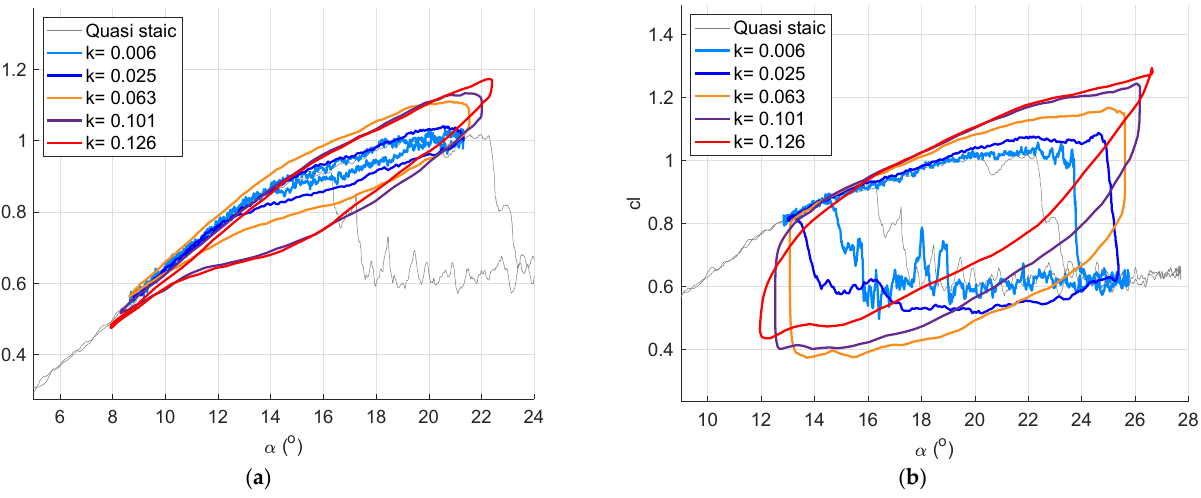
Figure 10. The lift force comparison for increasing reduced frequencies at ( a ) 15° and ( b ) 19° pitch offsets.